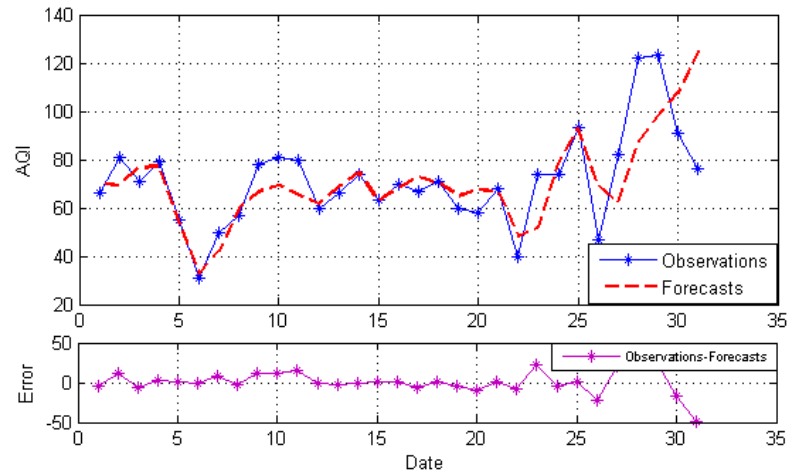
Figure 5. The forecasts and error based on EEMD-MM-NARNN.